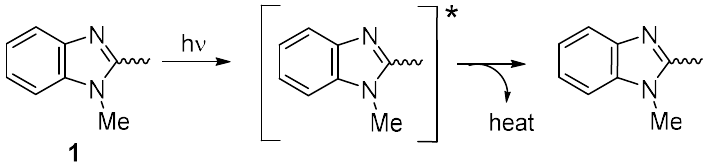
Figure 17. Organotin 1 acts as a UV absorber.